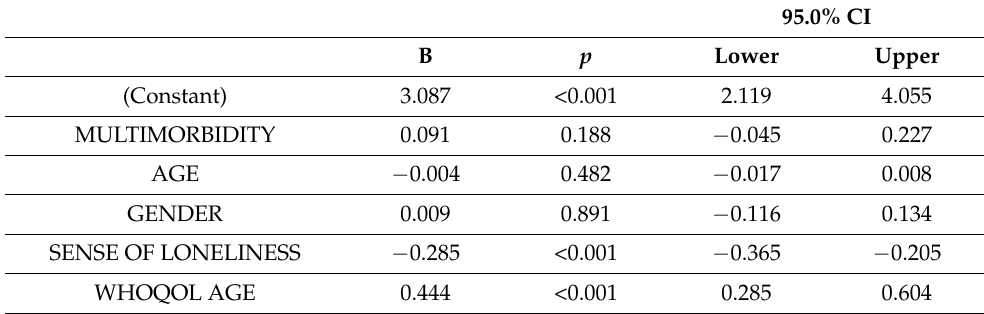
Table 3. Coefficients (dependent variable: FACT_G total